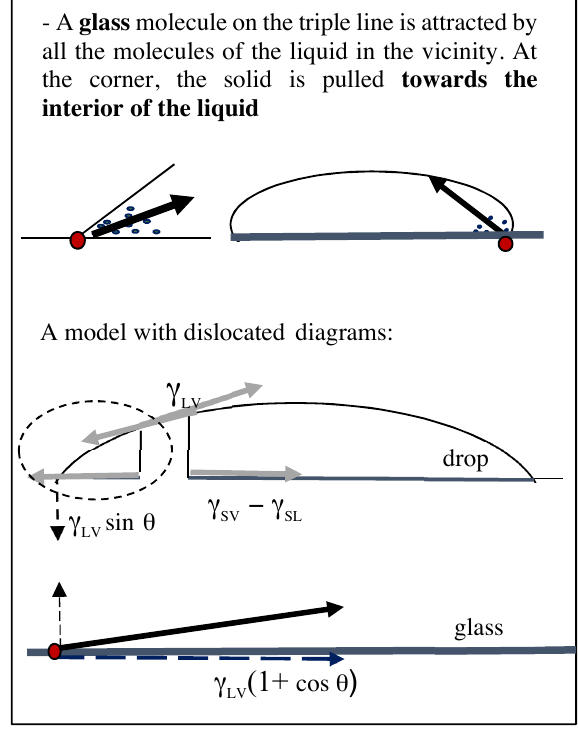
Fig.5. Elements of a model for the forces at play between a drop and its glass support, after